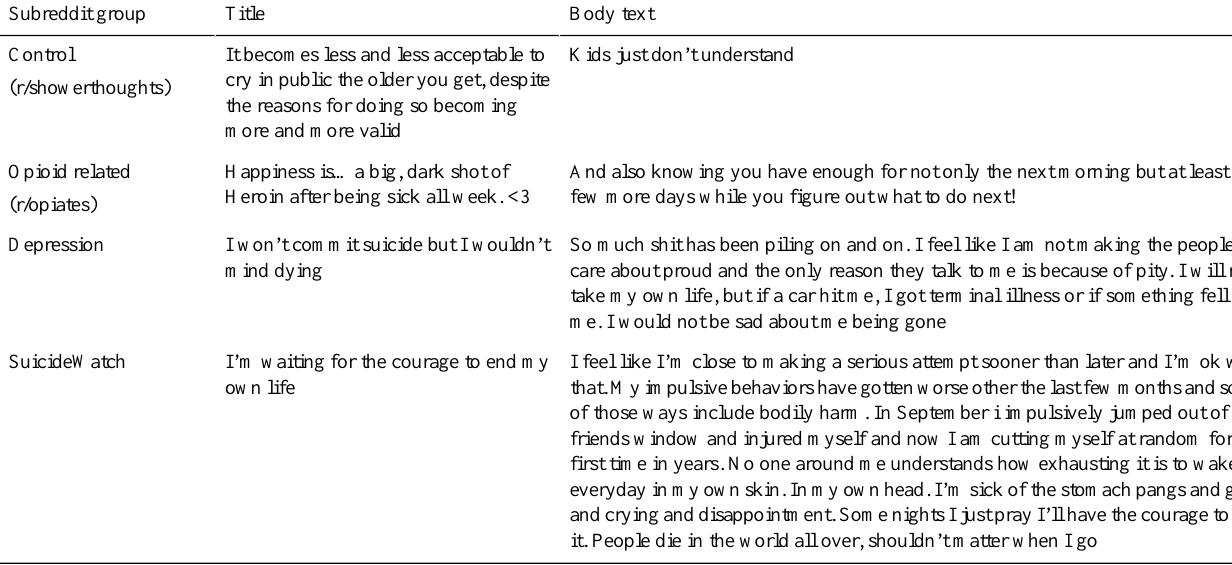
Table 1. Example posts from subreddits belonging to data groups.